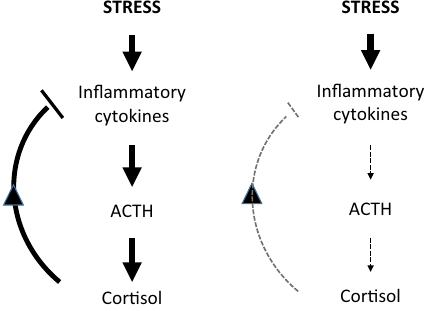
Figure 1. The role of the hypothalamic–pituitary–adrenal (HPA) axis as a regulator of stress response and inflammation. LEFT: Normally, the stress-induced release of cytokines, like IL-6, activates the HPA axis resulting in rapid increases of adrenocorticotropic hormone (ACTH) and cortisol. Cortisol will, as a feedback, suppress further release of cytokines. RIGHT: Hypothetically, a blunted HPA axis response leads to inadequate downregulation of stress-induced inflammatory